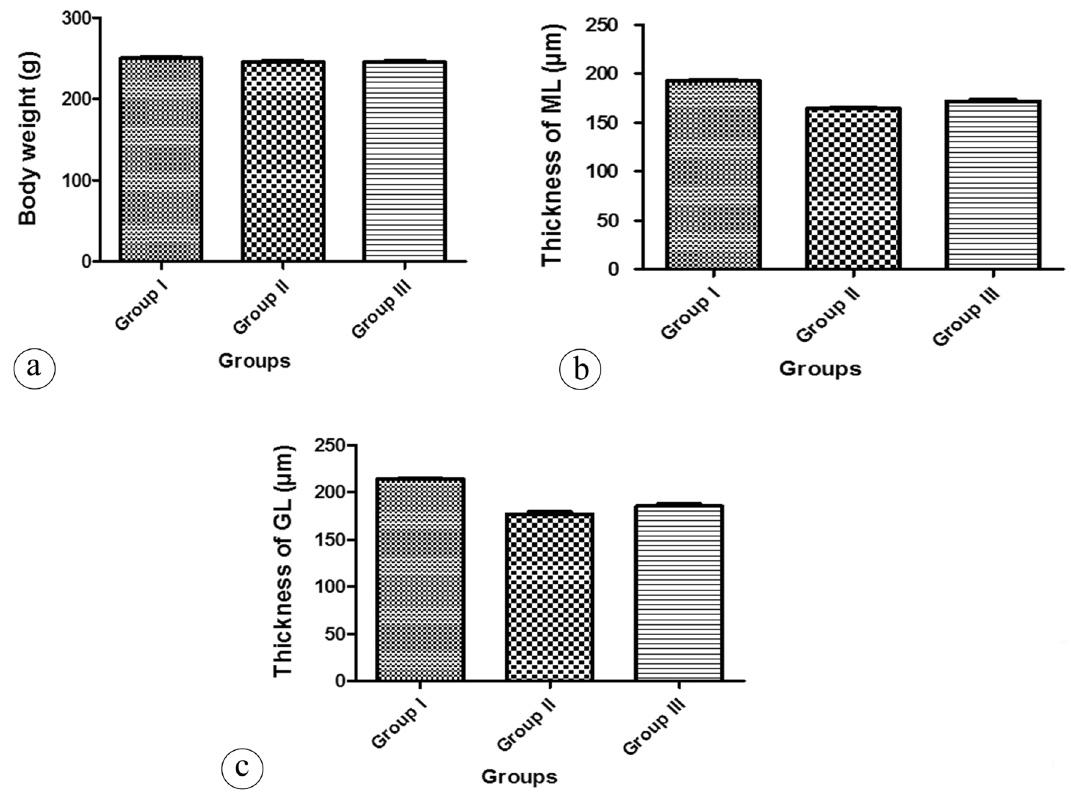
Figure 6. ( a ) A histogram showing the difference in the mean values of the body weight per gram in different groups. ( b ) A histogram showing the comparison of the mean values of the thickness of the molecular layer per µm in different groups. ( c ) A histogram showing the comparison of the mean values of the thickness of the granular layer per µm in different groups. The data is presented as Mean ± Standard Error.